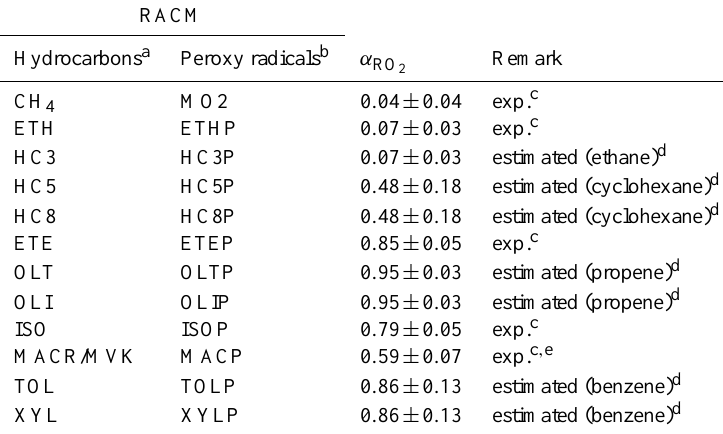
) used for the calculation of modelled HO ∗ 2